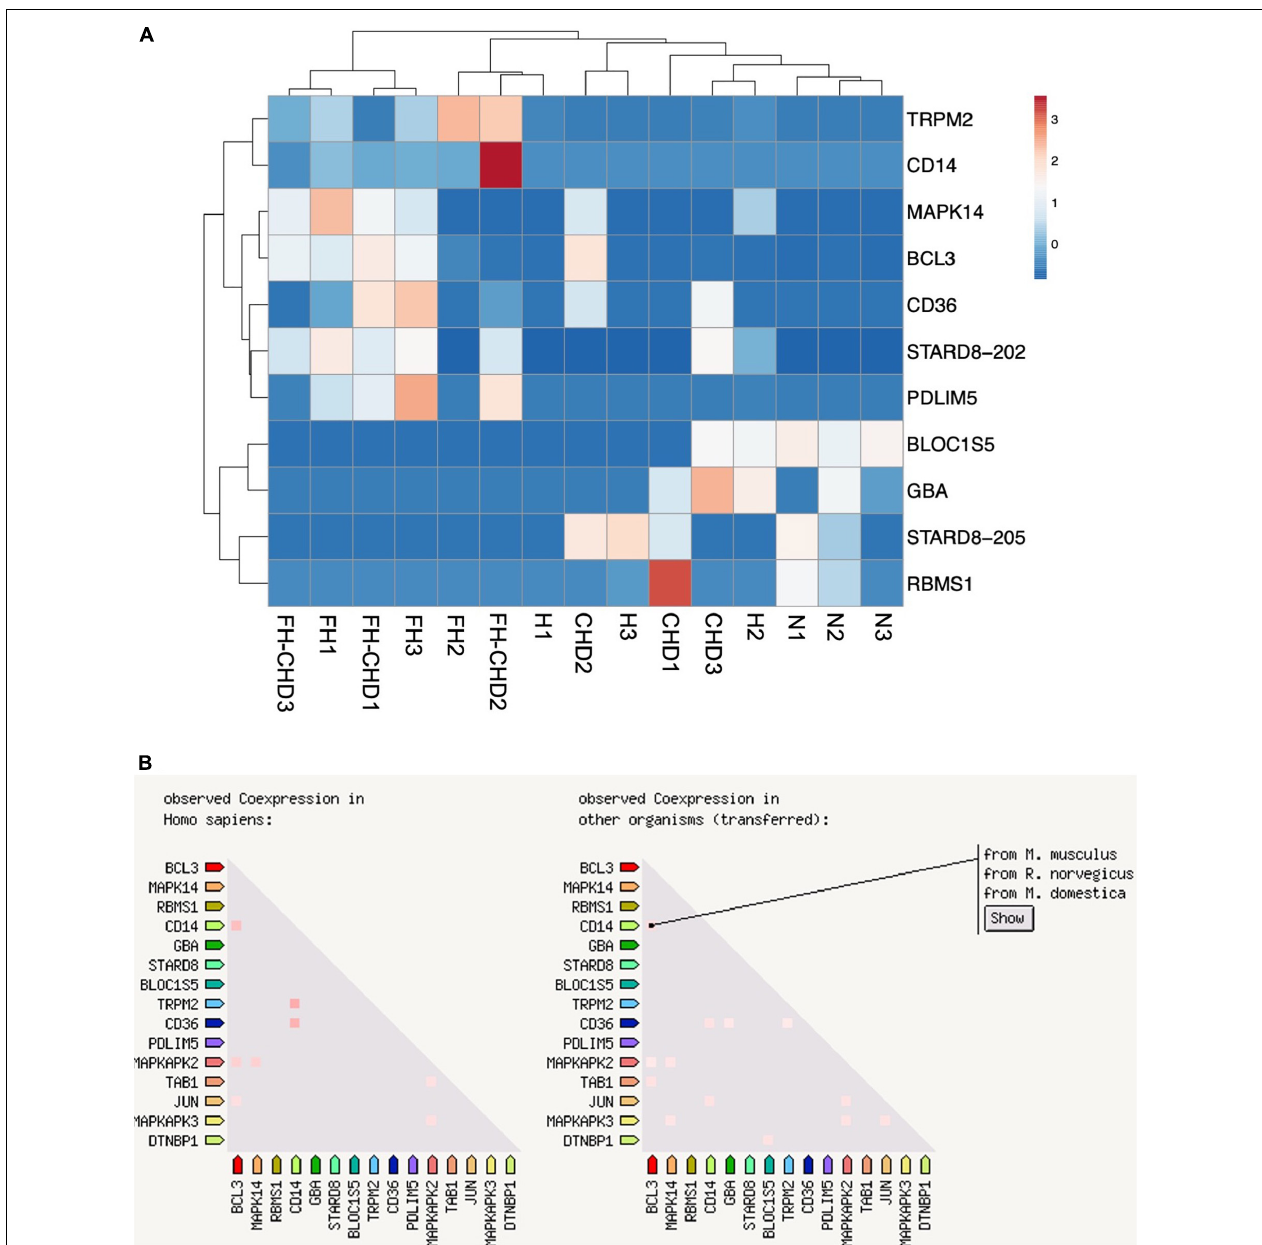
FIGURE 6 | Ten selected genes from 55 intersecting genes between familial hyperlipidemia (FH) and familial coronary heart disease (FH-CHD) groups. (A) Heat maps of the 10 differentially expressed transcripts in the patient groups versus the normal control group ( n = 3). (B) Co-expression of 10 selected genes. Note the high co-expression between CD14 and BCL3 , between TRMP2 and CD14 , and between CD14 and CD36 (left panel) in Homo sapiens and in other organisms (right panel).